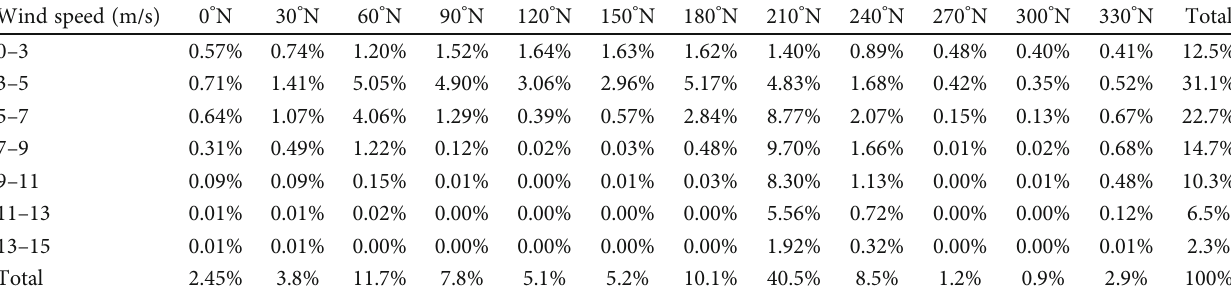
Figure 7: Wind roses (hindcasted wind data from Oceanweather). Table 1: Wind frequency (hindcasted wind data from